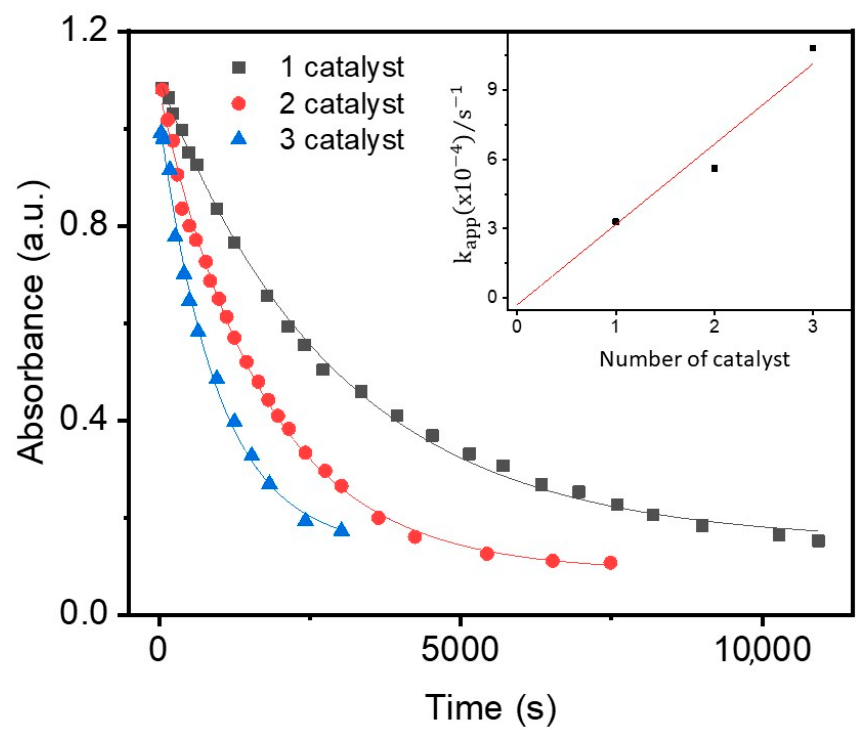
Figure 3. Kinetic trace of the absorbance at 400 nm during the reduction of p-NP in the presence of 1, 2, and 3 PDMS sponges doped with Pd nanoparticles, [p-NP] = 5 × 10 − 5 M, [NaBH 4 ] = 0.1 M and pH = 13. The solid lines represent the best fit of Equation (1) to the experimental data, k app = 3.3 × 10 − 4 s − 1 , 5.6 × 10 − 4 s − 1 and 10.8 × 10 − 4 s − 1 , respectively. The inset shows the variation of k app with the number of Au-doped PDMS sponges. The line represents the best fit of a straight line equation to the experimental data. Table 1. Apparent rate constants and the calculated TOFs, under the same experimental